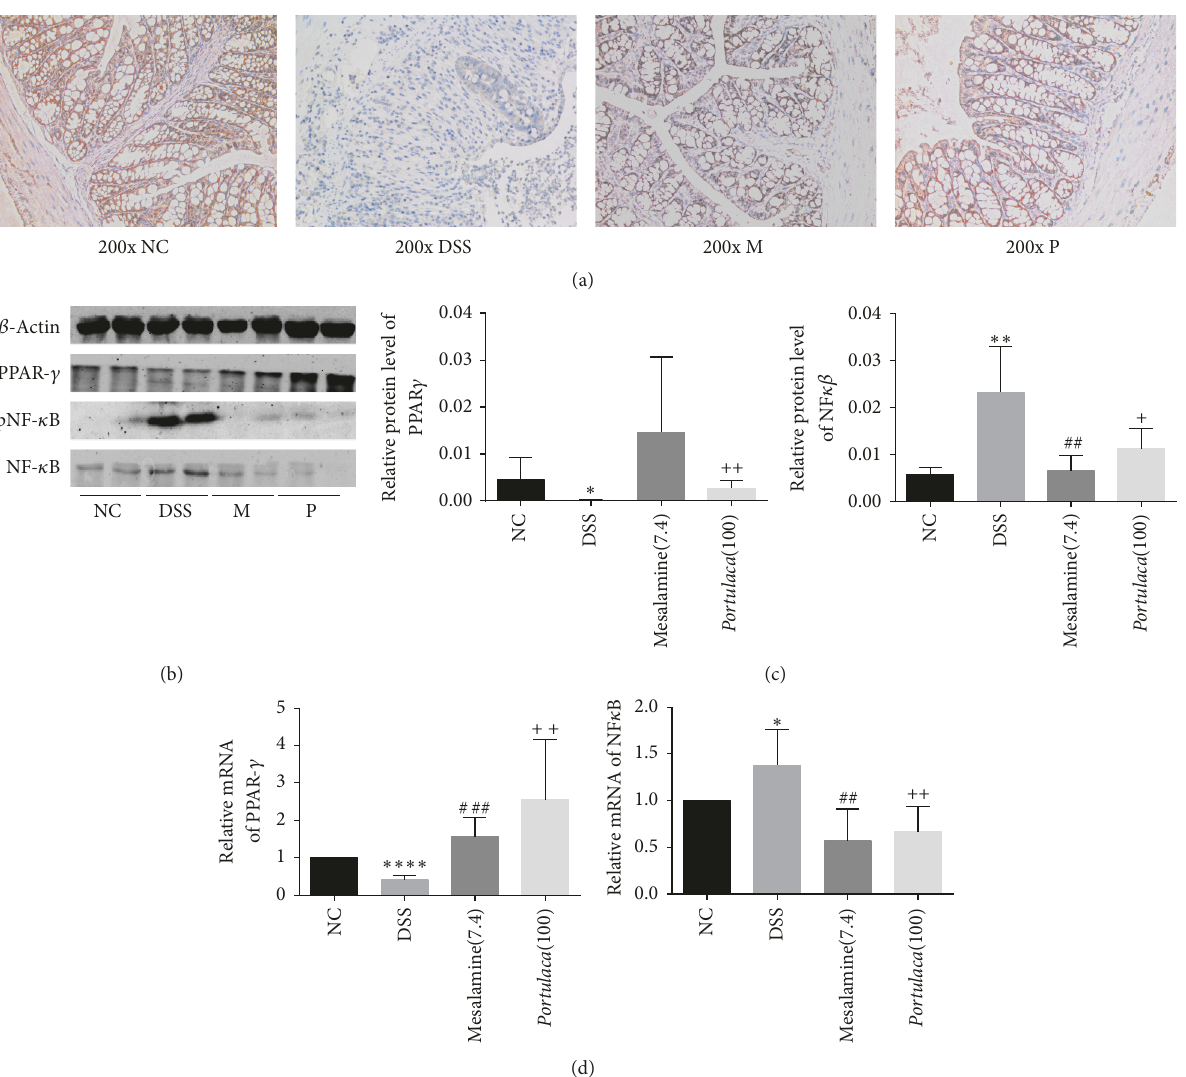
Figure 3: Effect of Portulaca extracts on NF- 𝜅 B and PPAR- 𝛾 expression in colonic tissue. Panel (a) represents the immunohistochemistry staining of PPAR- 𝛾 . (NC refers to negative control; DSS refers to DSS alone group; M refers to mesalamine group; P refers to Portulaca group, original magnification: × 200). Panel (b) shows the expression of PPAR- 𝛾 , NF- 𝜅 B, and pNF- 𝜅 B in colorectum tissues from western blot. Panel (c) shows the histograms of grey intensity for PPAR- 𝛾 and NF- 𝜅 B relative to 𝛽 -actin. Panel (d) shows the relative mRNA expression of PPAR- 𝛾 and NF- 𝜅 B from quantitative real-time PCR. (Data are presented as mean ± SD from six experiments. ∗ indicates comparison between DSS and NC; # indicates comparison between mesalamine and DSS; + indicates the comparison between Portulaca and DSS. The number of symbols indicates significance of difference; for example, four symbols indicate 𝑝 < 0.0001 ; three symbols indicate 𝑝 < 0.001 ; two symbols indicate 𝑝 < 0.01 ; and one symbol indicates 𝑝 < 0.05